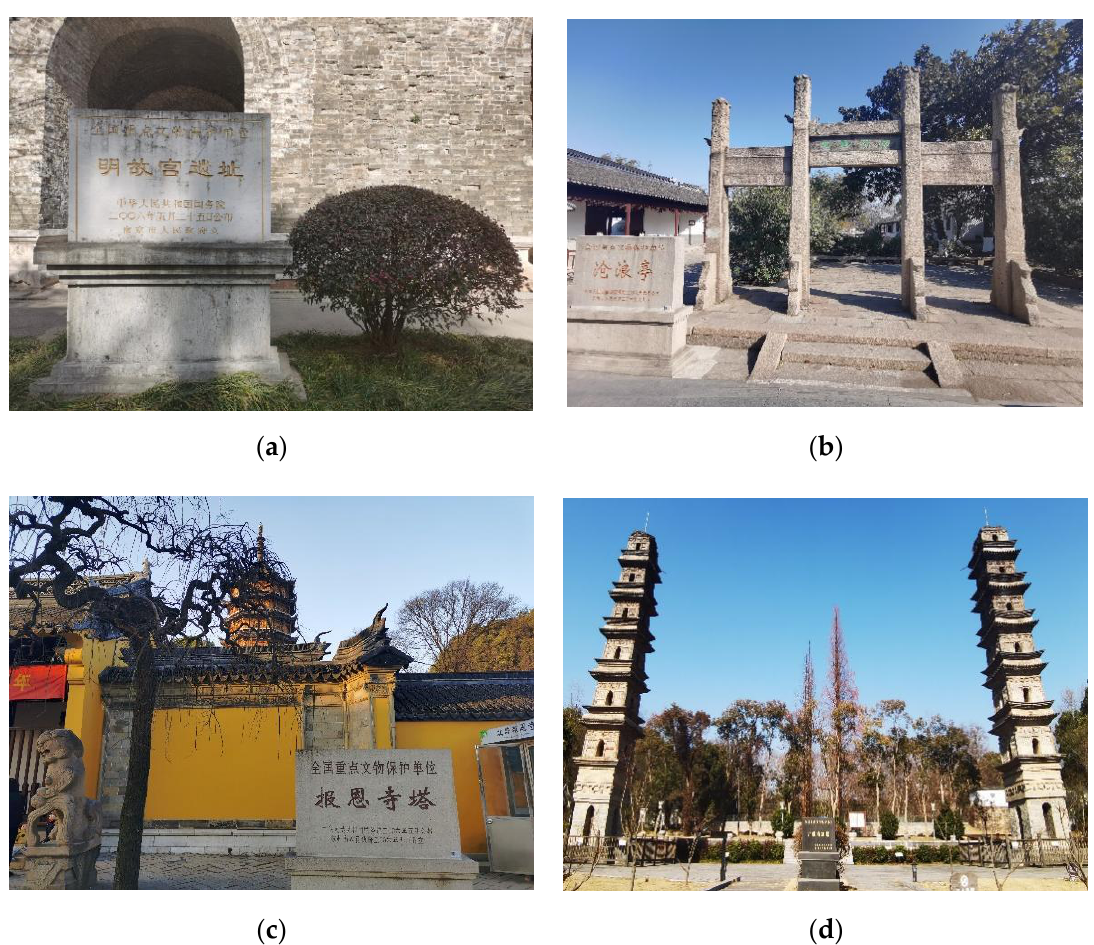
Figure 3. Examples of Archaeological Sites: ( a ) The Palace Museum of Ming Dynasty in Nanjing country, ( b ) The Canglang Pavilion in Suzhou country, ( c ) The Baoen Temple Pagoda in Suzhou country, ( d ) The Two pagodas of Guangjiao Temple in Xuancheng